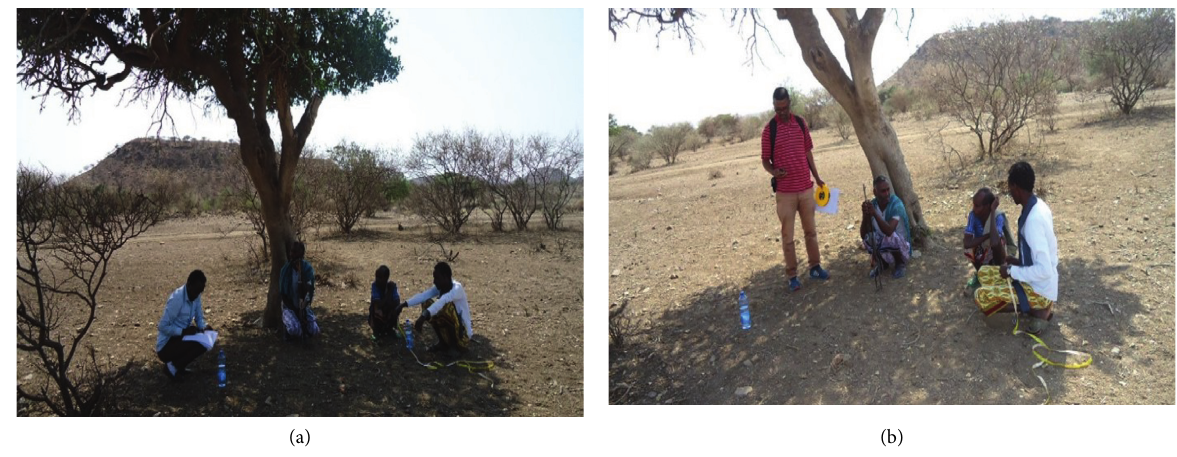
Figure 4: Semistructured interview with